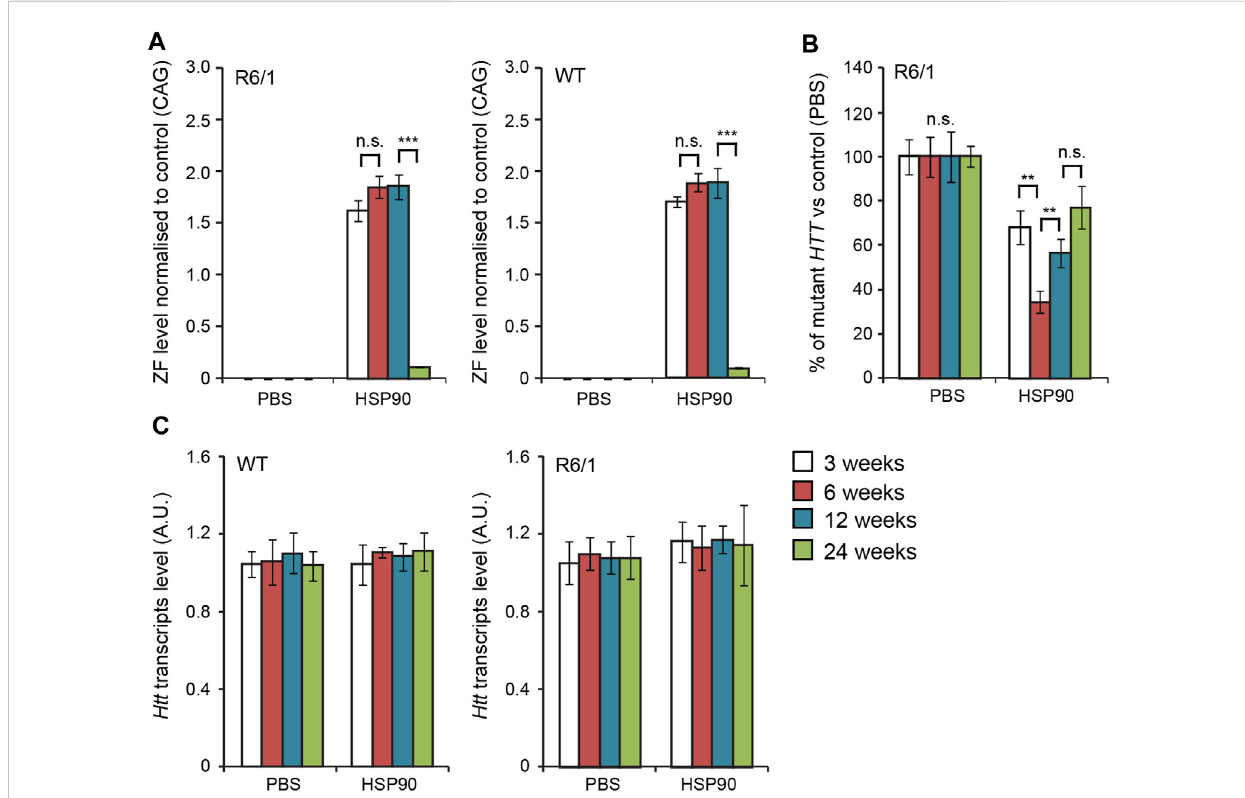
FIGURE 2 Long-term effects of bilateral intraventricular injection of AAV expressing mZF-KRAB zinc fi nger under the HSP90 promoter. (A) Zinc fi nger expression over time. mZF-KRAB transcript levels from whole brains were assayed by qRT-PCR at 3, 6, 12, and 24 weeks after viral (or PBS control) injections, in WT or R6/1 neonates. (B) Zinc fi nger repression of mutant Huntingtin in R6/1 mice. mut HTT (exon 1) expression levels in the whole brain samples from the various treatments were compared to transcript levels in PBS controls, by qRT-PCR. (C) Veri fi cation of lack of cross-reactivity of mZF-KRAB with short WT HTT alleles. WT HTT (exon 1) expression levels were quanti fi ed in the same treatment samples as above. All transcript levels were normalized to three housekeeping genes (see Supplementary Figure S2). Error bars are S.E.M ( n = 4). ** p < 0.01, *** p < 0.001, n.s. = not signi fi